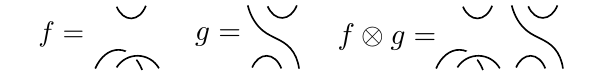
Figure 2 . An illustration of the tensor product de(cid:12)nition. Here f : [4] f g : [7] (cid:10) !